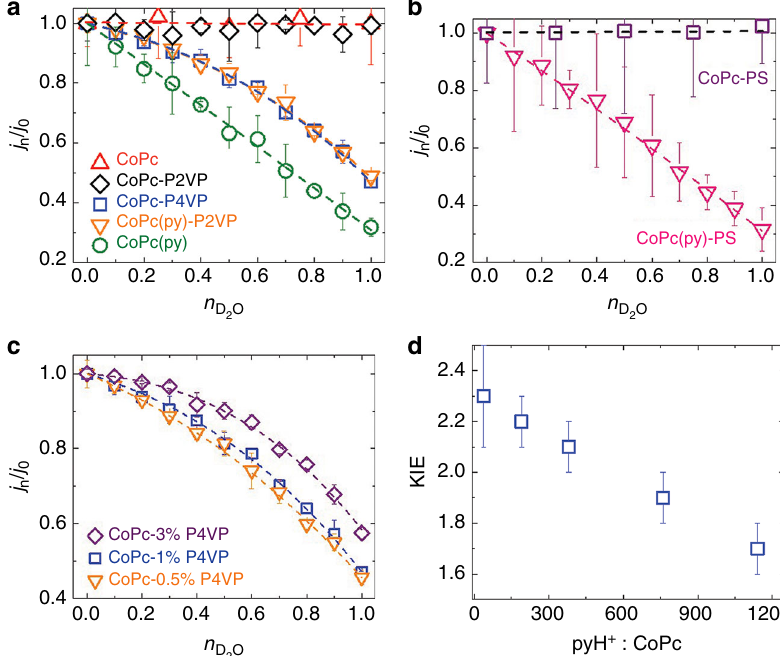
Fig. 5 Proton Inventory Studies of CoPc and Related systems. a Proton inventory studies of CO 2 reduction by CoPc (red triangles), CoPc-P2VP (black diamonds), CoPc-P4VP (blue squares), CoPc(py)-P2VP (orange triangles) and CoPc(py) (green circles). The red dashed line is the guide to the eye for CoPc and CoPc-P2VP ( j n = j 0 at every n measured), and the blue, orange and green dashed lines are fi ts to the data using equation (2). The resulting values for ϕ and Z are shown in Table 1. Note that KIE = j H / j D . b Proton inventory studies of CO 2 reduction by CoPc-PS (purple squares) and CoPc(py)-PS (pink triangles). The purple dashed line is the guide to the eye for CoPc-PS case ( j n = j 0 at every n measured), and the pink dashed line is a fi t to the data using Eq. (2). The resulting values for ϕ and Z are shown in Table 1 Note that KIE = j H / j D . c Proton inventory studies of CO 2 reduction by CoPc-P4VP drop-cast from deposition solutions with different P4VP loadings: 0.5 % w/v (orange triangles), 1% w/v (blue squares), and 3% w/v (purple diamonds). The dashed lines are fi ts to the data by Eq. (2) and the resulting values for ϕ and Z are shown in Table 2. d KIE value decreases with increasing the pyH + : CoPc ratio in the polymer. All reported values are averages from three or more independent measurements, and all errors are given as standard